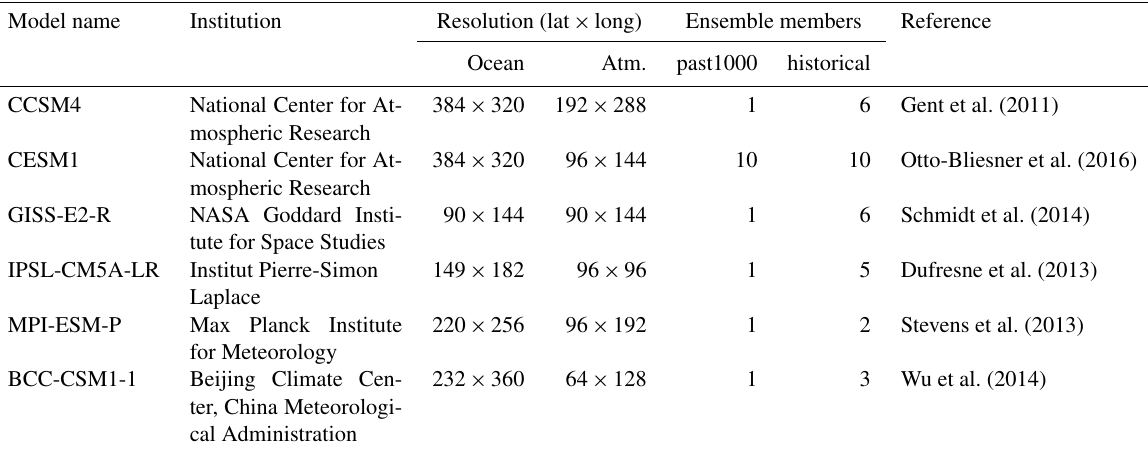
Table 1. Modelling centres, parameters and references of the PMIP3/CMIP5 models used in this study. Model